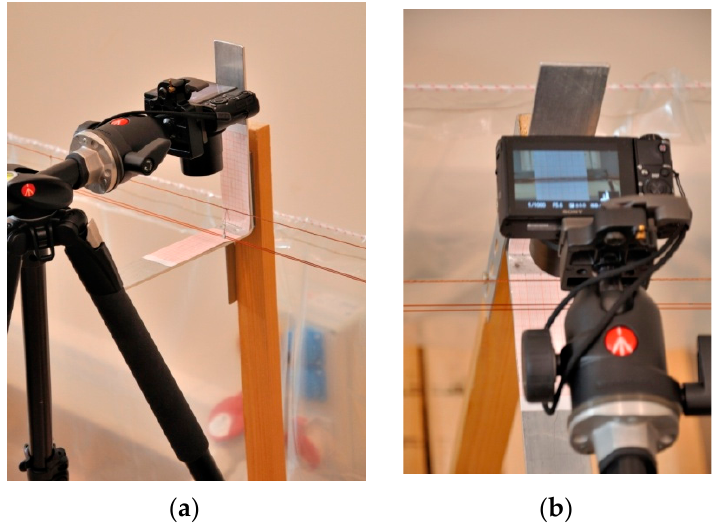
Figure 9. Optical setup for measuring displacement of the wires.